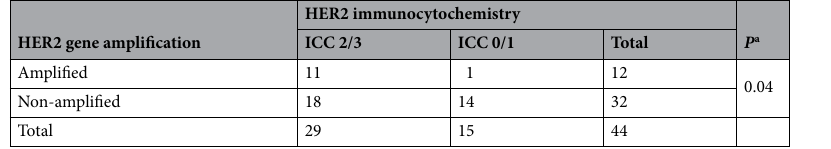
Table 4. Association of HER2 immunocytochemistry with HER2 gene amplification in dogs with urothelial carcinoma. a Fisher’s exact test.